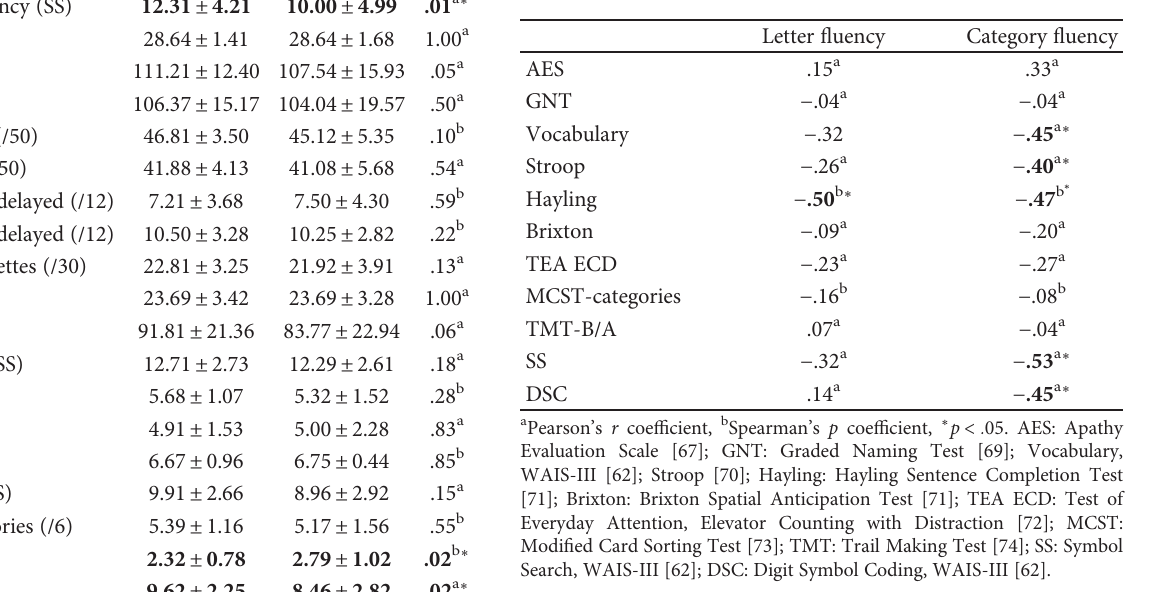
Table 5: Correlations between decline in verbal fl uency and changes in other measures after